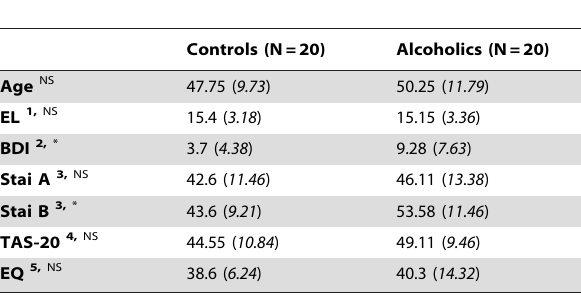
Table 1. Alcoholic and control individuals’ characteristics: mean ( S.D.